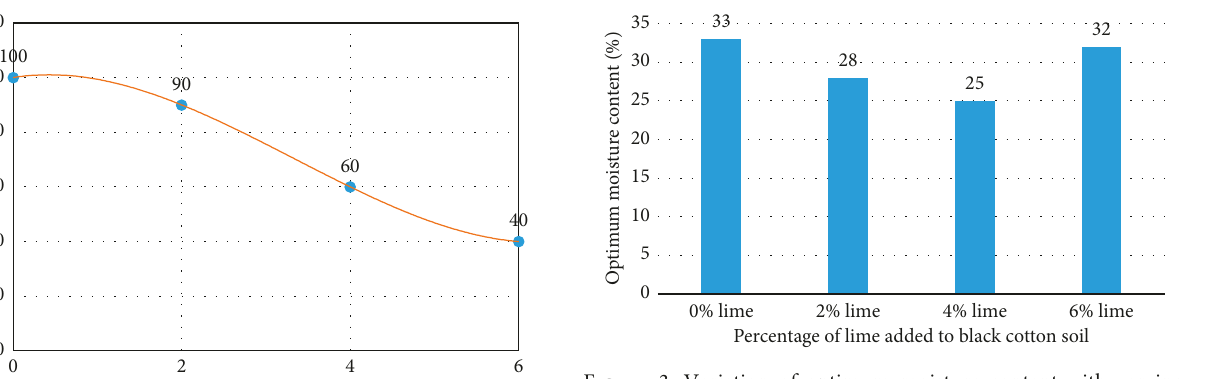
Figure 3: Variation of optimum moisture content with varying percentages of lime.